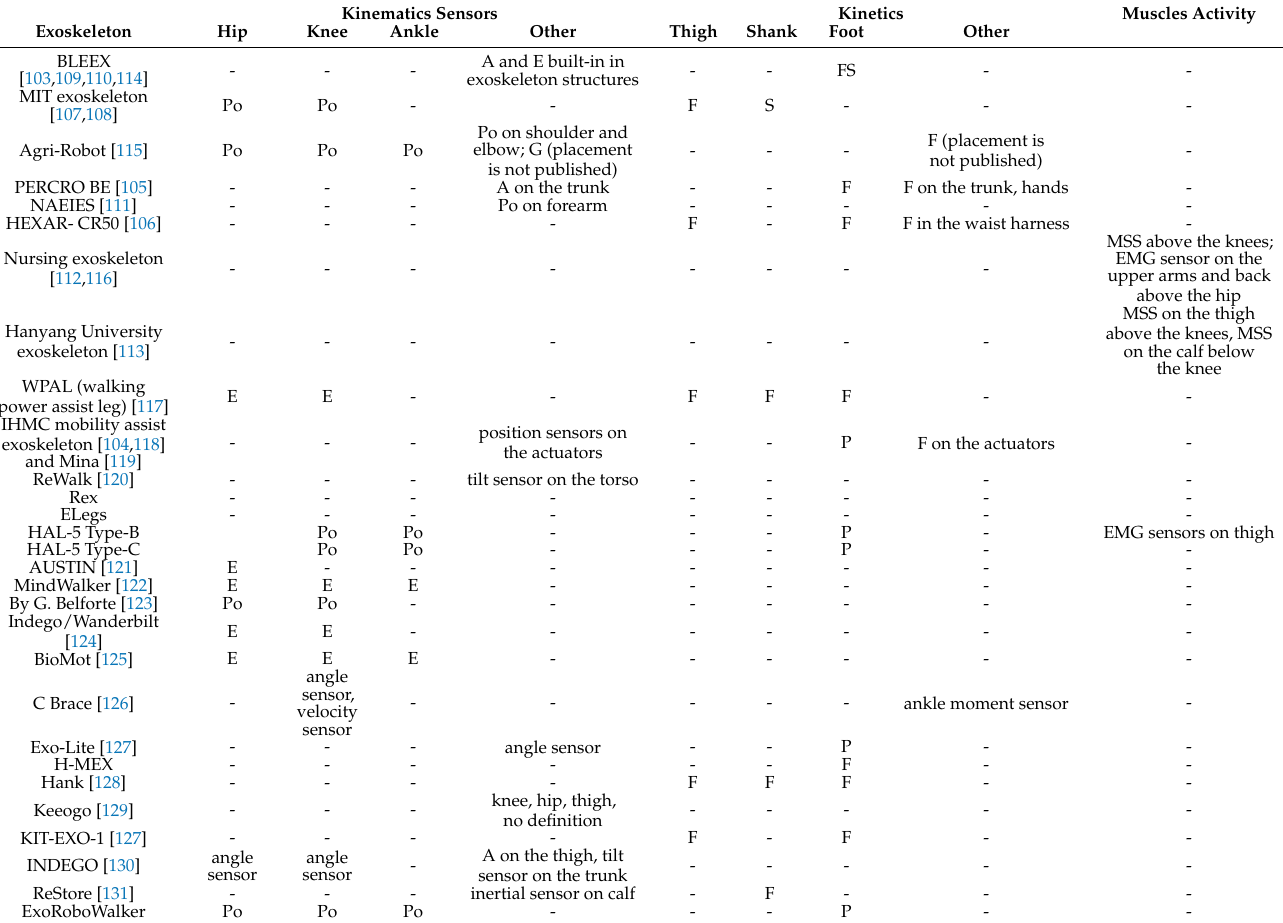
Table 3. Placement of sensors employed in lower limbs exoskeletons. A—acceleration sensor, Po—potentiometer, G—gyroscope, E—encoders F—force sensor, S—strain gauge, FS—foot switch, P—pressure